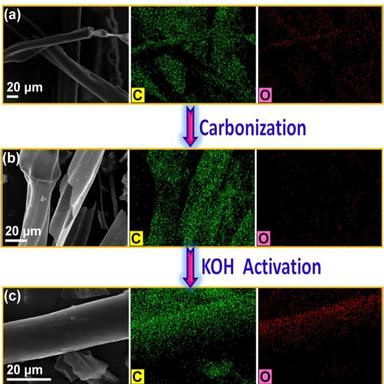
Elemental mapping images of (a) APF, (b) TC and (c) TPC samples.